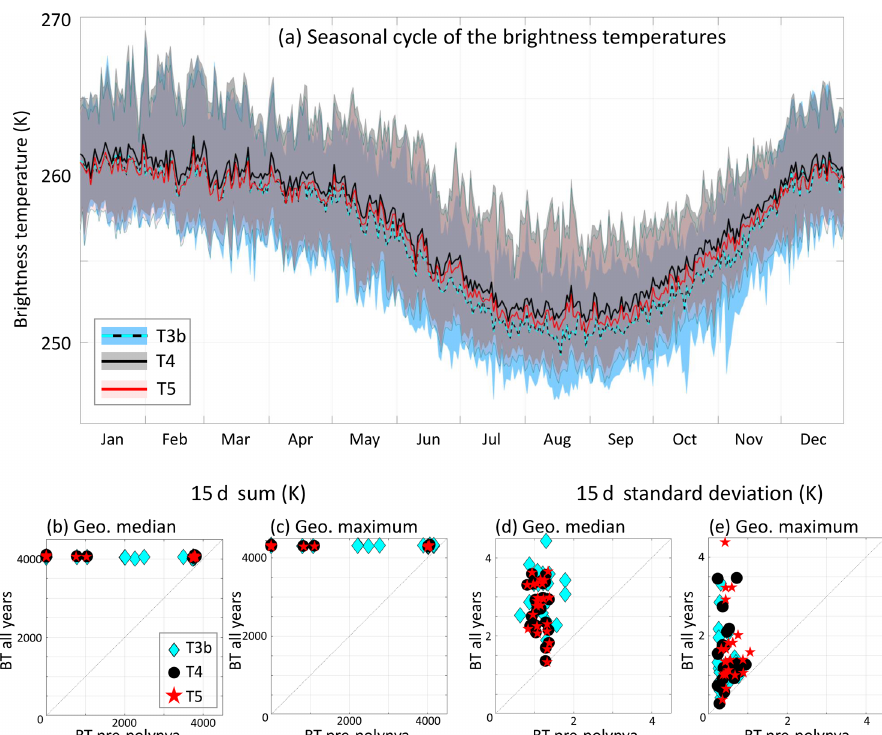
Figure 5. For the three bands, (a) 1982–2019 median (thick line) and 10th to 90th percentile (shading) infrared brightness temperature value for each day of year. Panels (b) to (d) demonstrate the narrow range of the infrared brightness temperature (BT) statistics over the 15d leading to each polynya ( x axis) compared to that on the same date in all years ( y axis): 15d sum of the geographical (b) median and (c) maximum; 15d standard deviation of the geographical (d) median and (e) maximum. One point per polynya event: cyan diamonds are used for the temperature band T3b; black circle for T4; red star for T5. The thin black line is the unit